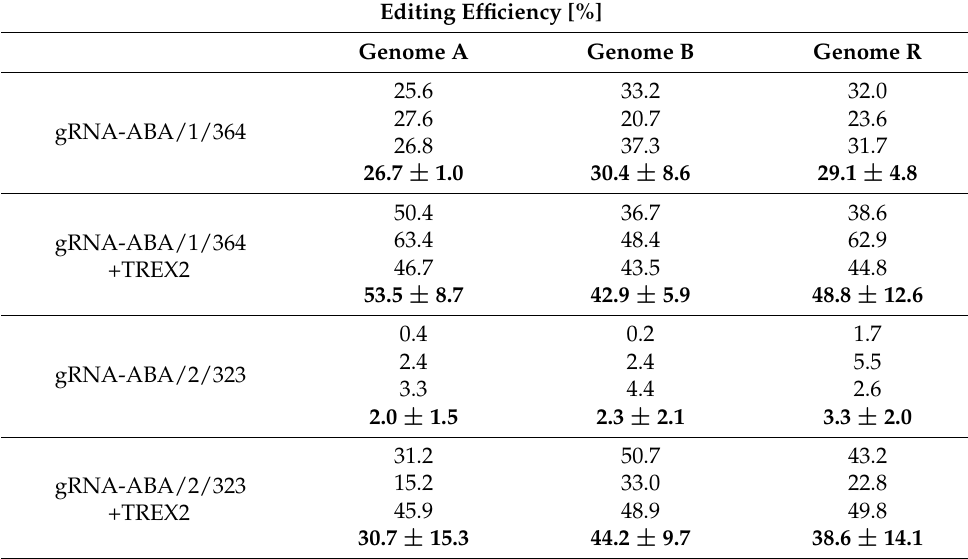
Table 4. Gene editing efficiency for gRNA-ABA/1/364 and gRNA-ABA/2/323 vectors containing or lacking the TREX2 component, analyzed in transfected triticale protoplasts using amplicon deep- sequencing. Mean editing efficiency values ± SD are indicated in bold